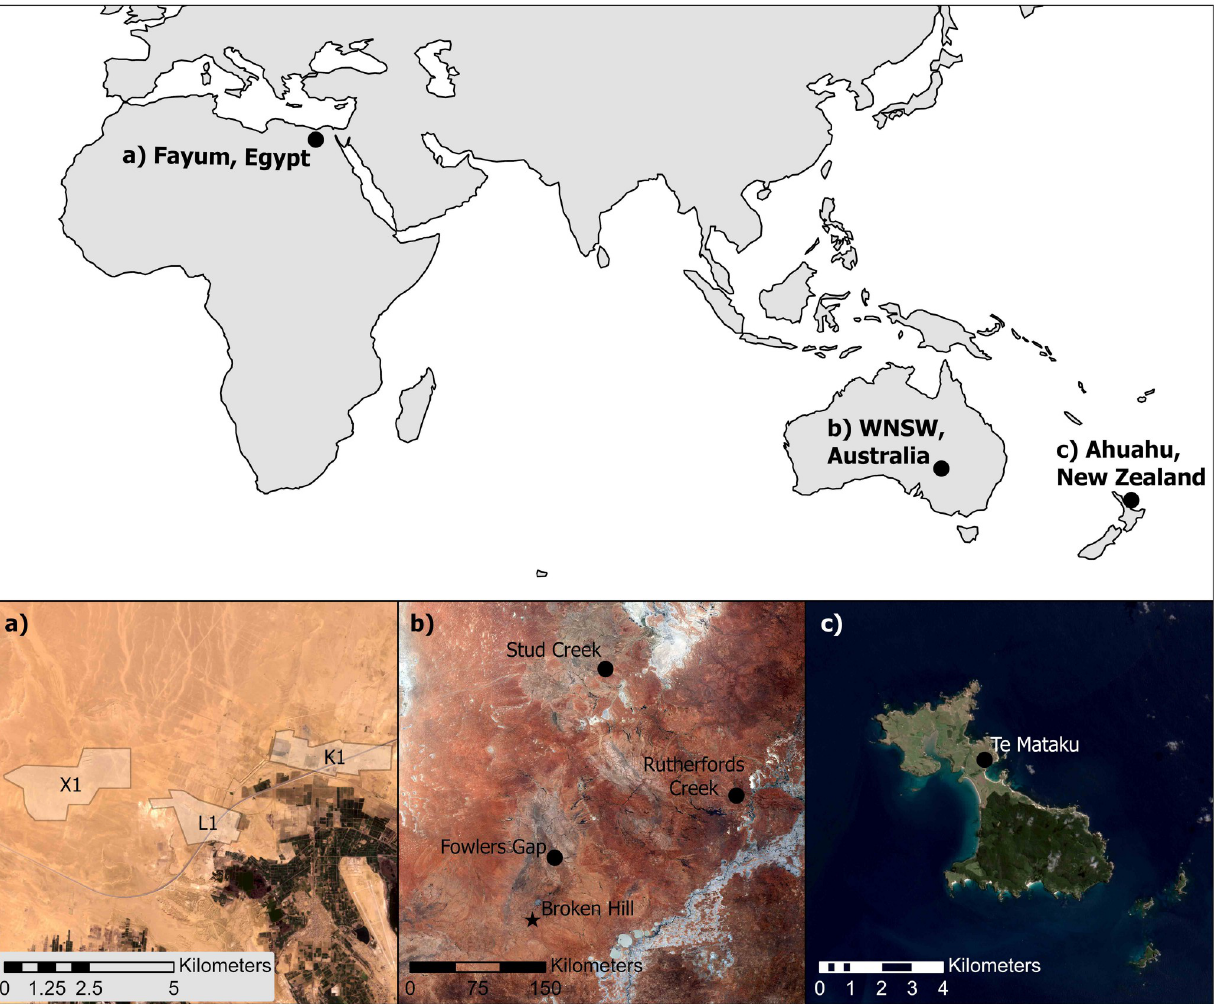
Fig 1. Locations of the three case studies. a. Fayum north shore showing the X1, L1, and K1 study areas [11,12]; b. western New South Wales Archaeological project areas with the town of Broken Hill shown for reference [13–15];c. Te Mataku archaeological site Ahuahu, New Zealand [16]. Produced from ESA remote sensing data. Contains Copernicus Sentinel data [2022]. Satellite imagery from Sentinel-2 data available at https://scihub. copernicus.eu/; Country outlines from https://www.naturalearthdata.com/.